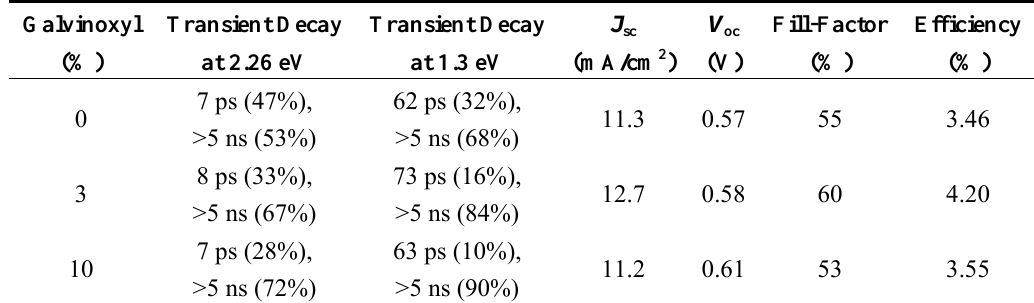
Table 1. The transient decay parameters (lifetime and relative contribution) and photovoltaic device parameters of annealed polymer regio-regular 3 hexyl thiophene/ 6,6-phenyl-C -butyric acid methyl ester PCBM (RR-P3HT/PCBM) (1.2:1) films with 61 different percent (%) of Galvinoxyl radical